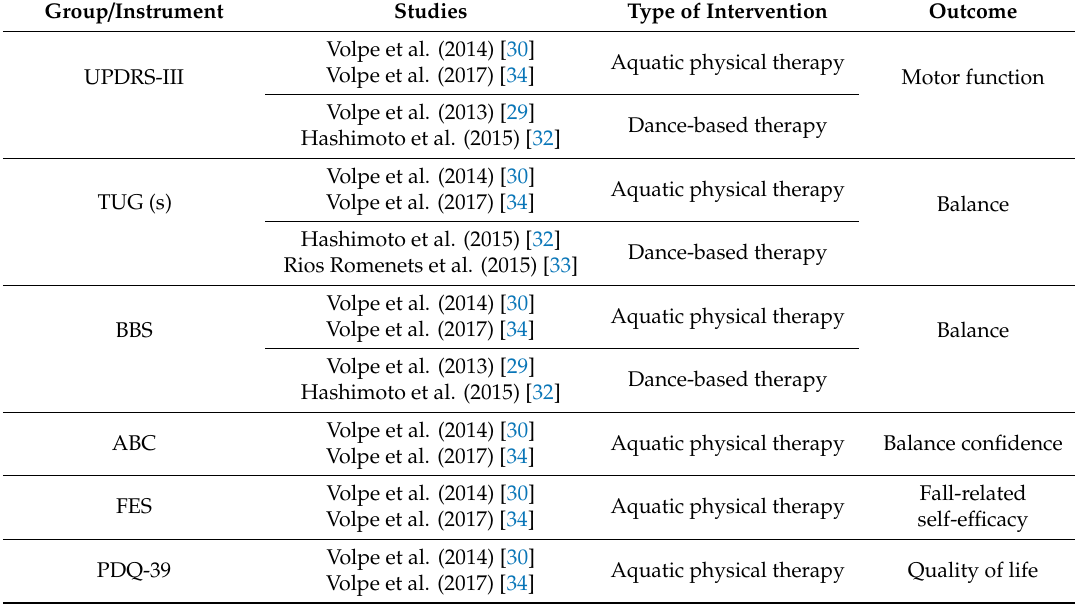
Table 4. Classification of the RCTs according to the measuring instrument, type of intervention and outcome.